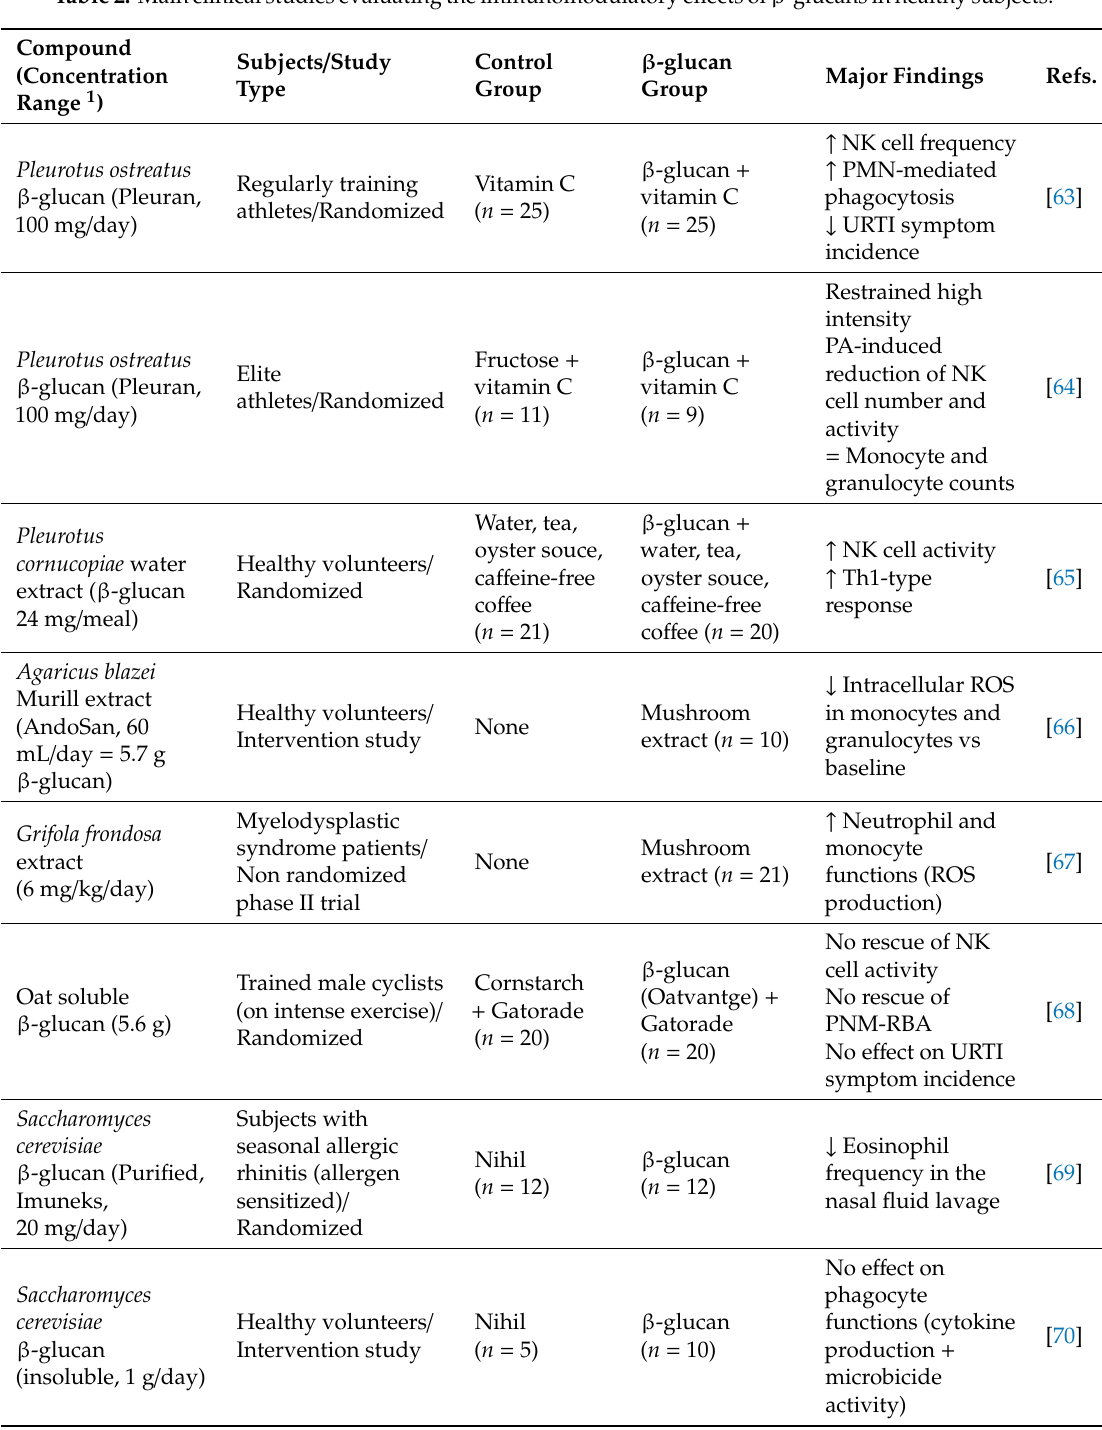
Table 2. Main clinical studies evaluating the immunomodulatory e ff ects of β -glucans in healthy